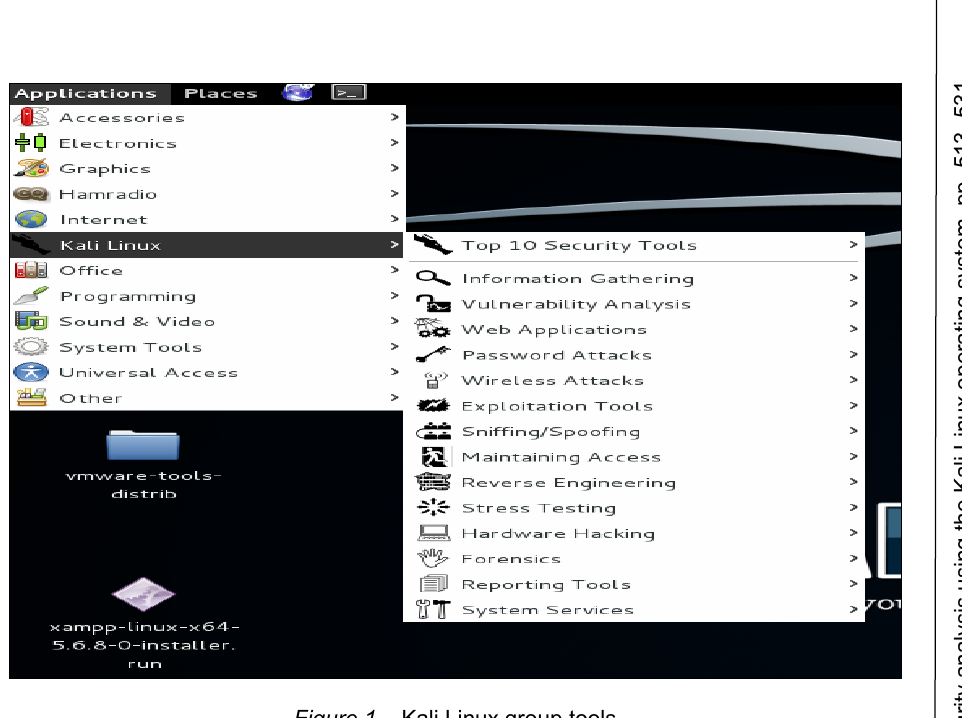
Figure 1 – Kali Linux group tools Рис . 1 – список инструментов Kali Linux Slika – 1 Grupa alata Kali